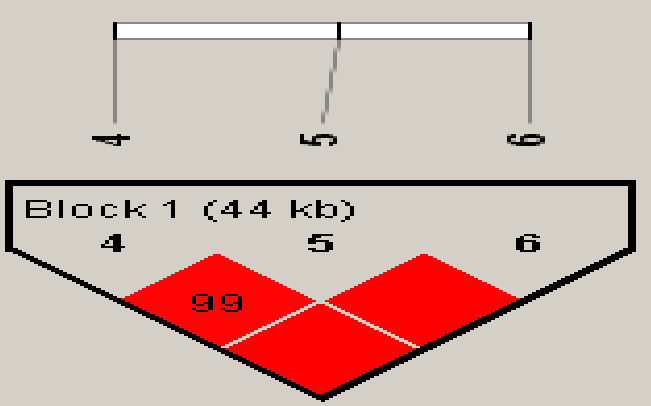
Figure 1. The linkage disequilibrium (LD) plot of the 3 SNPs of the ATG16L1 gene using Haploview with confidence bounds color scheme. All SNPs were in strong LD. Table 2. Direct sequencing demonstrated that the frequencies of ATG16L1 polymorphisms and haplotypes were associated with susceptibility to AOSD.